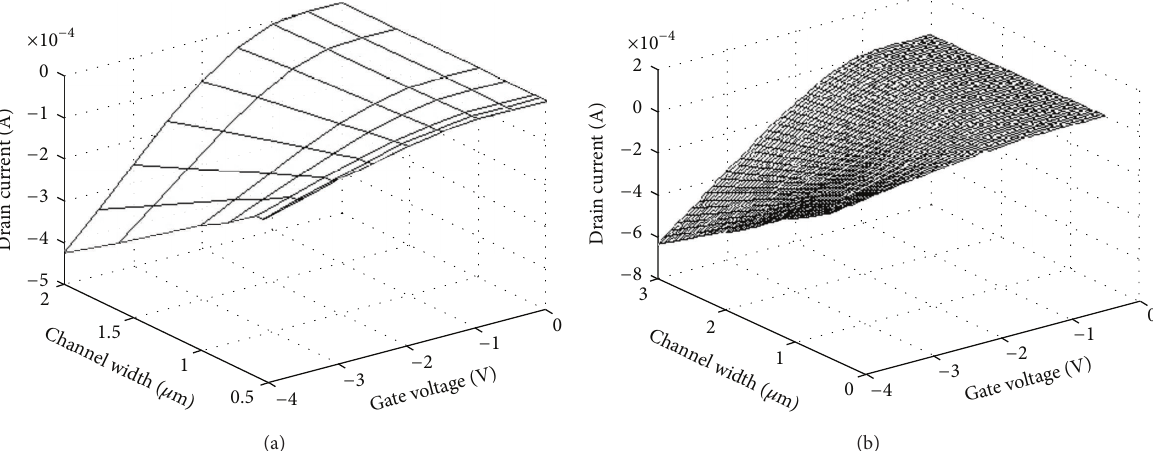
Figure 11: The 3D-like 𝐼 𝑑 (a) measurement data surface and (b) prediction data surface versus 𝑊 and 𝑉 𝑔 of the group 2A samples (as 𝑉 𝑑 = −3